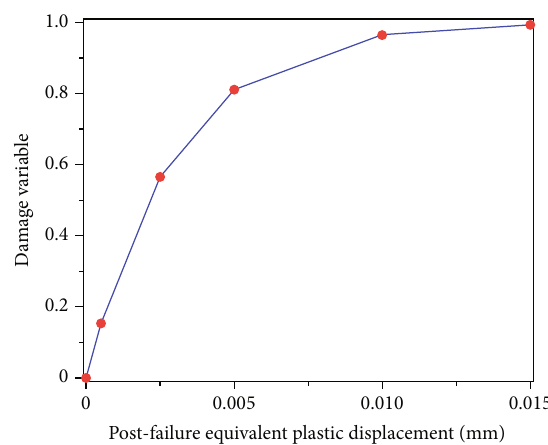
Figure 11: Relationship between damage variable and postfailure equivalent plastic